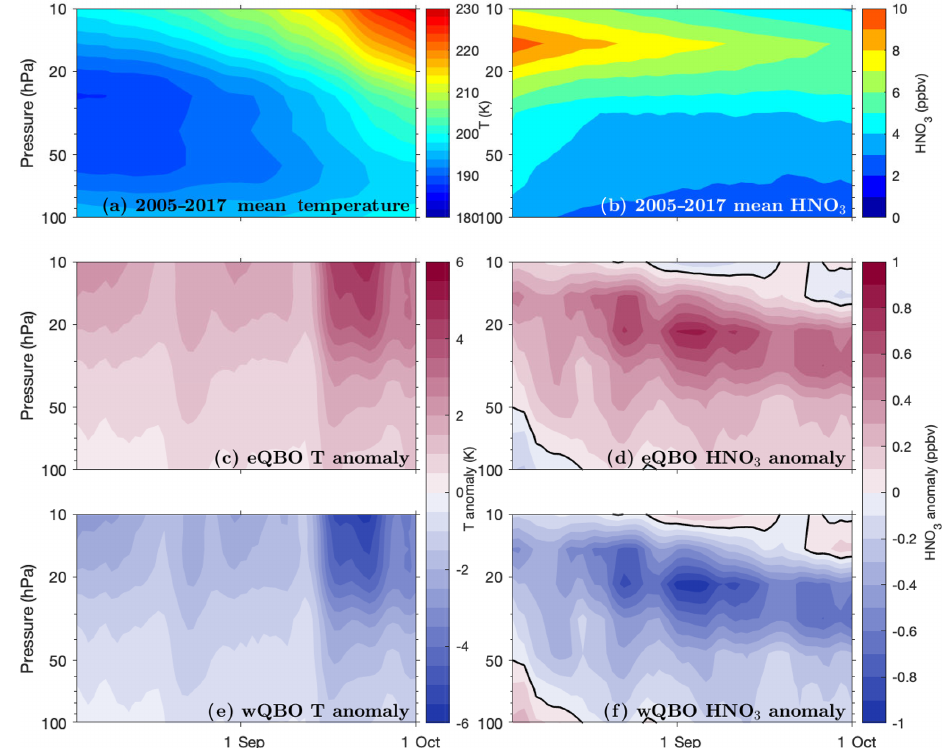
Figure 8. (a) The 3d running mean MLS temperature from 2005 to 2017 (5K contour interval), and (b) the 3d running mean MLS HNO 3 from 2005 to 2017 (1ppbv contour interval). Panels (a) and (b) are both averaged over the region from 60 to 82 ◦ S for the lower stratosphere for the late winter–early spring period from 2005 to 2017. (c) The HNO 3 anomaly (the mean shown in panel a has been subtracted) for years with eQBO (the contour interval is 0.1ppbv, and the black contour shows the zero anomaly). (d) The temperature anomaly (mean shown in panel b has been subtracted) for years with eQBO (the contour interval is 1K, and the black contour shows the zero anomaly). Panel (e) is the same as panel (c) but for years with wQBO, and panel (f) is the same as panel (d) but for years with